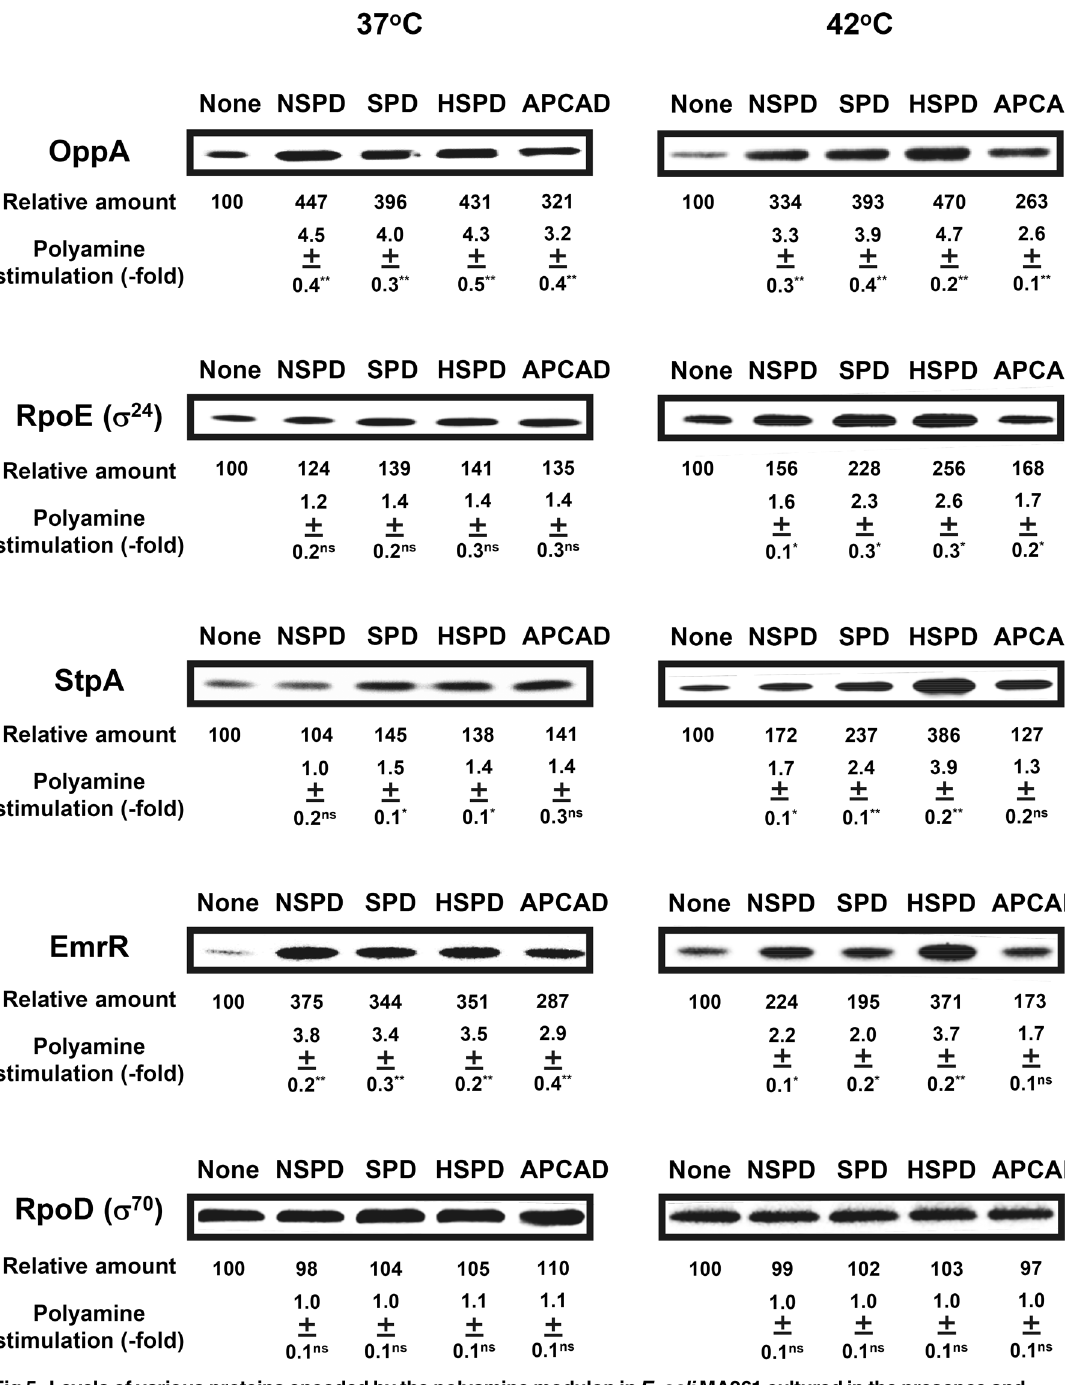
PLOS ONE | DOI:10.1371/journal.pone.0159494 July 19,